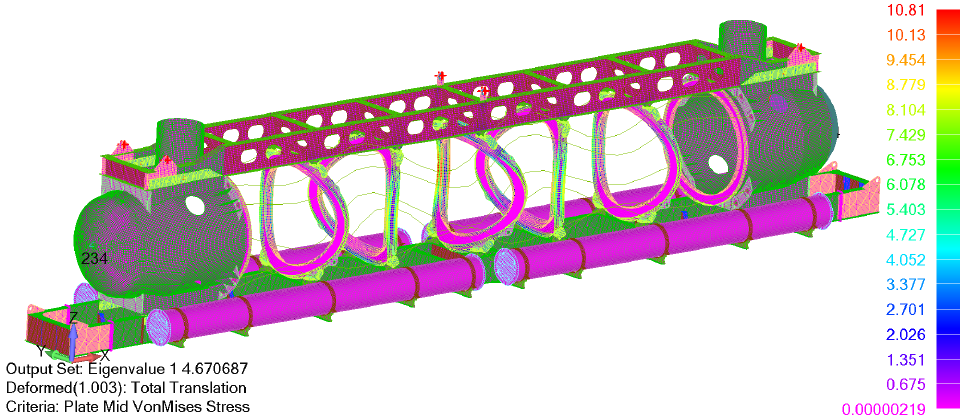
Figure 9. Buckling mode for structural assembly.